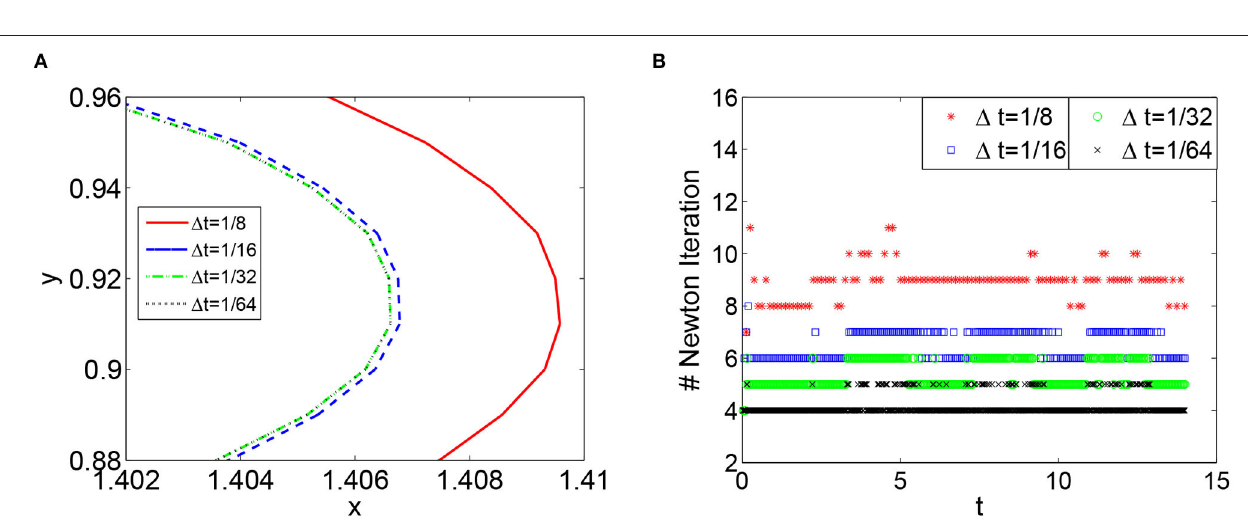
FIGURE 2 | The isopotential lines V m is obtained from the BE method with a small timestep size 1 t zoomed region of (A) to clearly display the different isopotential lines. (C) Contours for the transmembrane potential V m of an anisotropic bidomain equation at T 8.75 from the high precision solution. =